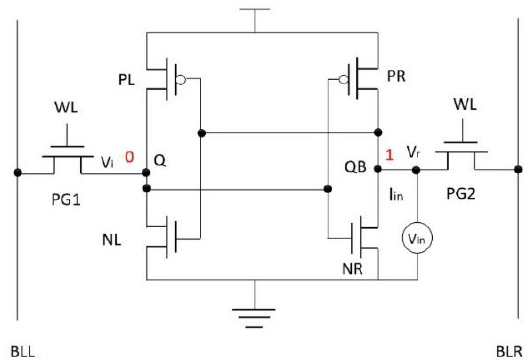
Figure 5. Leakage current stability analysis schematic.